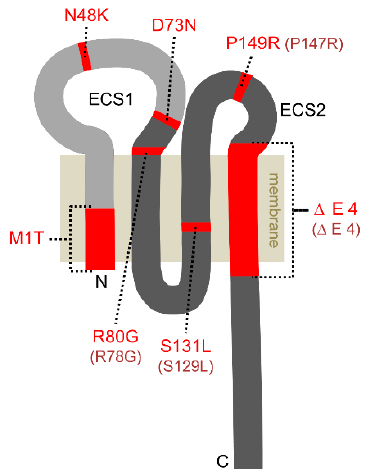
Figure 1. Predicted topology of claudin-10. The two major isoforms claudin-10a and claudin-10b differ in their first transmembrane segment and most of the first extracellular segment (ECS1), both shown in light grey. The remaining protein sequence is identical (shown in dark grey). The mutations discovered to date (red) comprise single amino acid substitutions or large deletions (M1T, Δ E4) and affect either both claudin-10a and claudin-10b or only claudin-10b. The existing claudin-10a variants with respective residue numbering are depicted in parentheses.